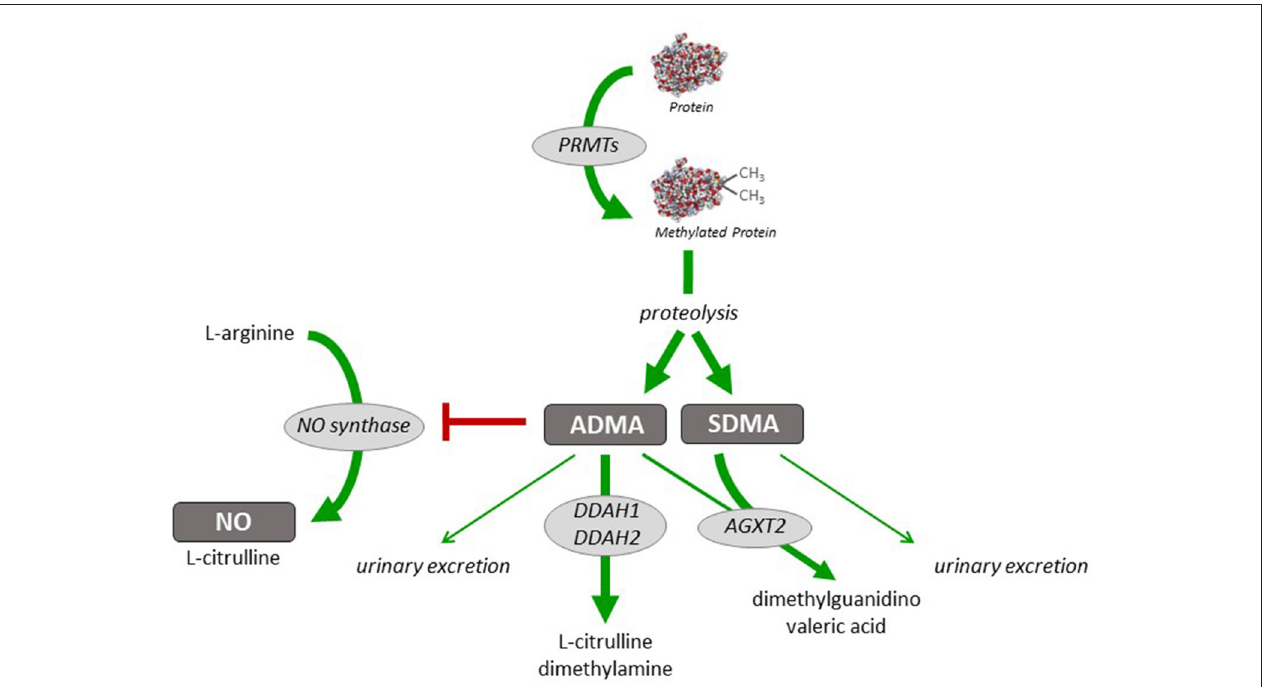
FIGURE 1 | Schematic representation of pathways of dimethylarginine biosynthesis and metabolism. Dimethylarginines are formed during (di-)methylation of protein-bound L-arginine residues by a family of protein arginine N-methyltransferases (PRMTs). Free ADMA and SDMA are released during physiological hydrolytic protein turnover. Asymmetric dimethylarginine (ADMA) inhibits nitric oxide (NO) synthesis from L-arginine, whilst symmetric dimethylarginine (SDMA) does not directly interfere with NO synthase activity. ADMA is metabolically degraded to L-citrulline and dimethylamine by either of two isoforms of dimethylarginine dimethylaminohydrolase (DDAH). Both ADMA and SDMA can be cleaved by alanine glyoxylate aminotransferase-2 (AGXT2); this enzyme is the major pathway of SDMA clearance. Minor amounts of both ADMA and SDMA can also be excreted into the